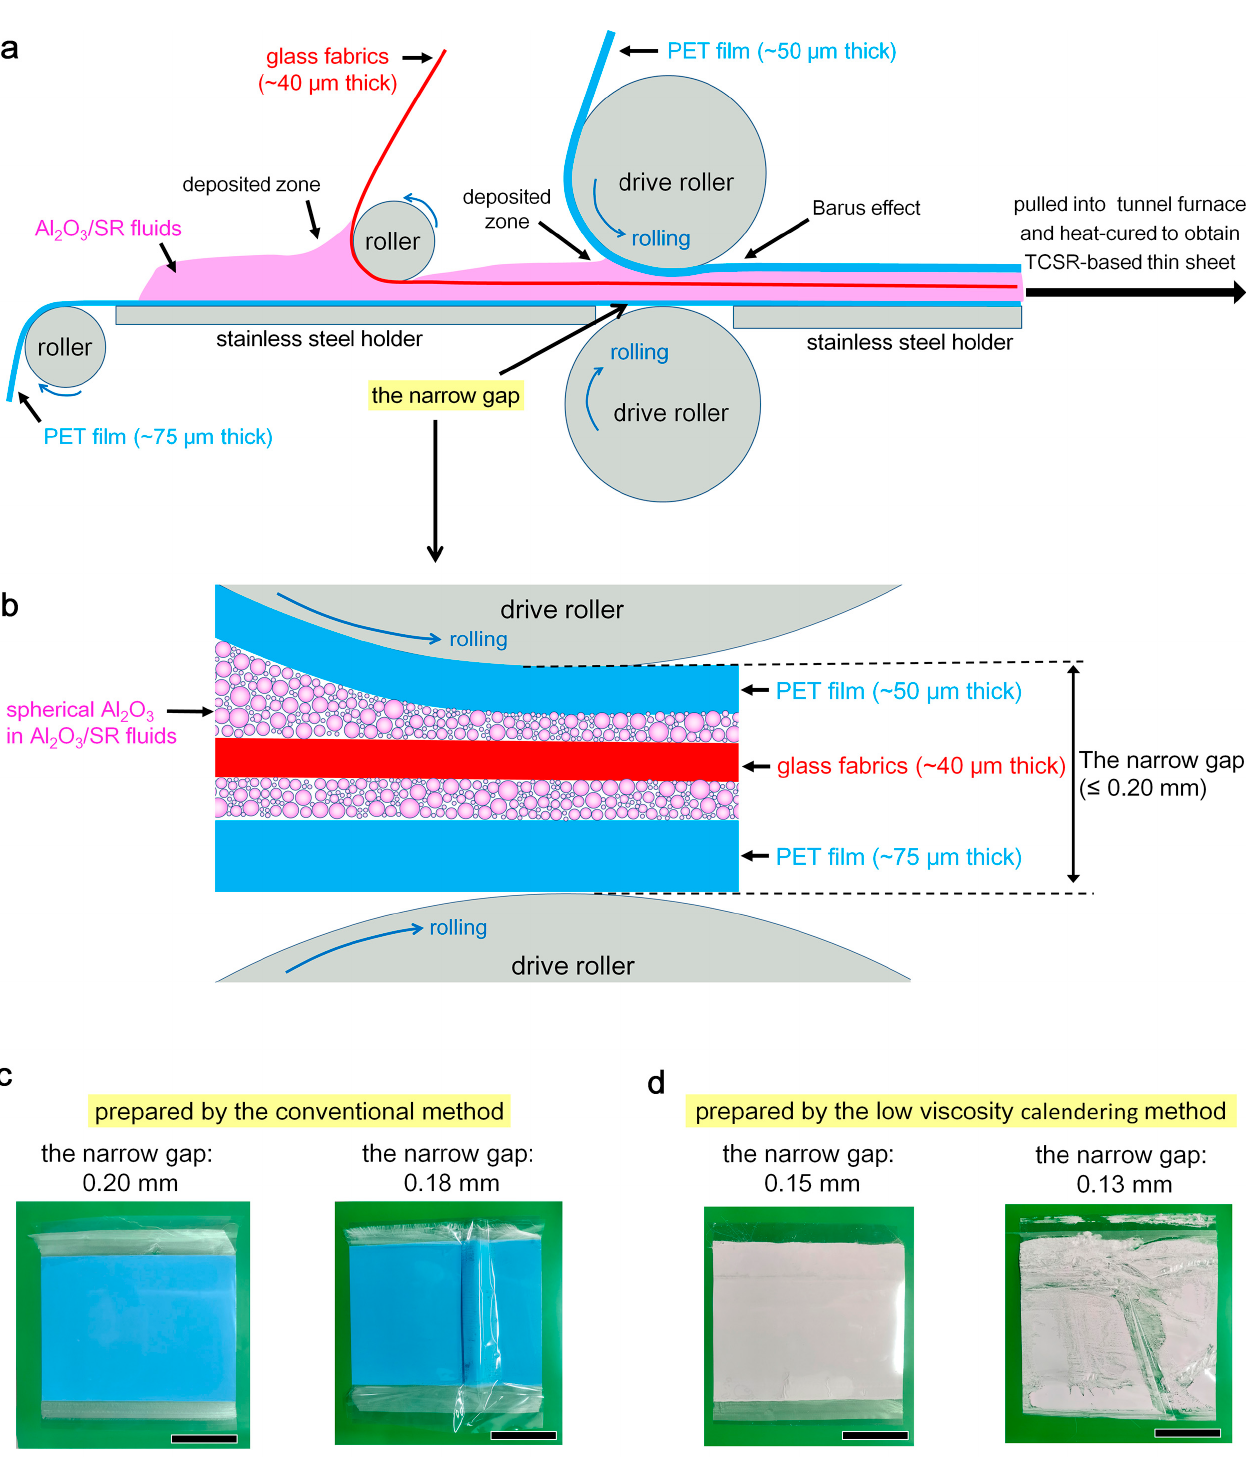
Figure 6. ( a ) Schematic diagram of the calendering process of Al 2 O 3 /SR fluids; ( b ) Schematic diagram of the narrow gap where alumina particles are forced to move and cross; ( c ) Photos showing TSCS-based thin sheets prepared by the conventional method with different narrow gaps; ( d ) Photos showing TSCS-based ultra-thin sheets prepared by the low-viscosity calendering